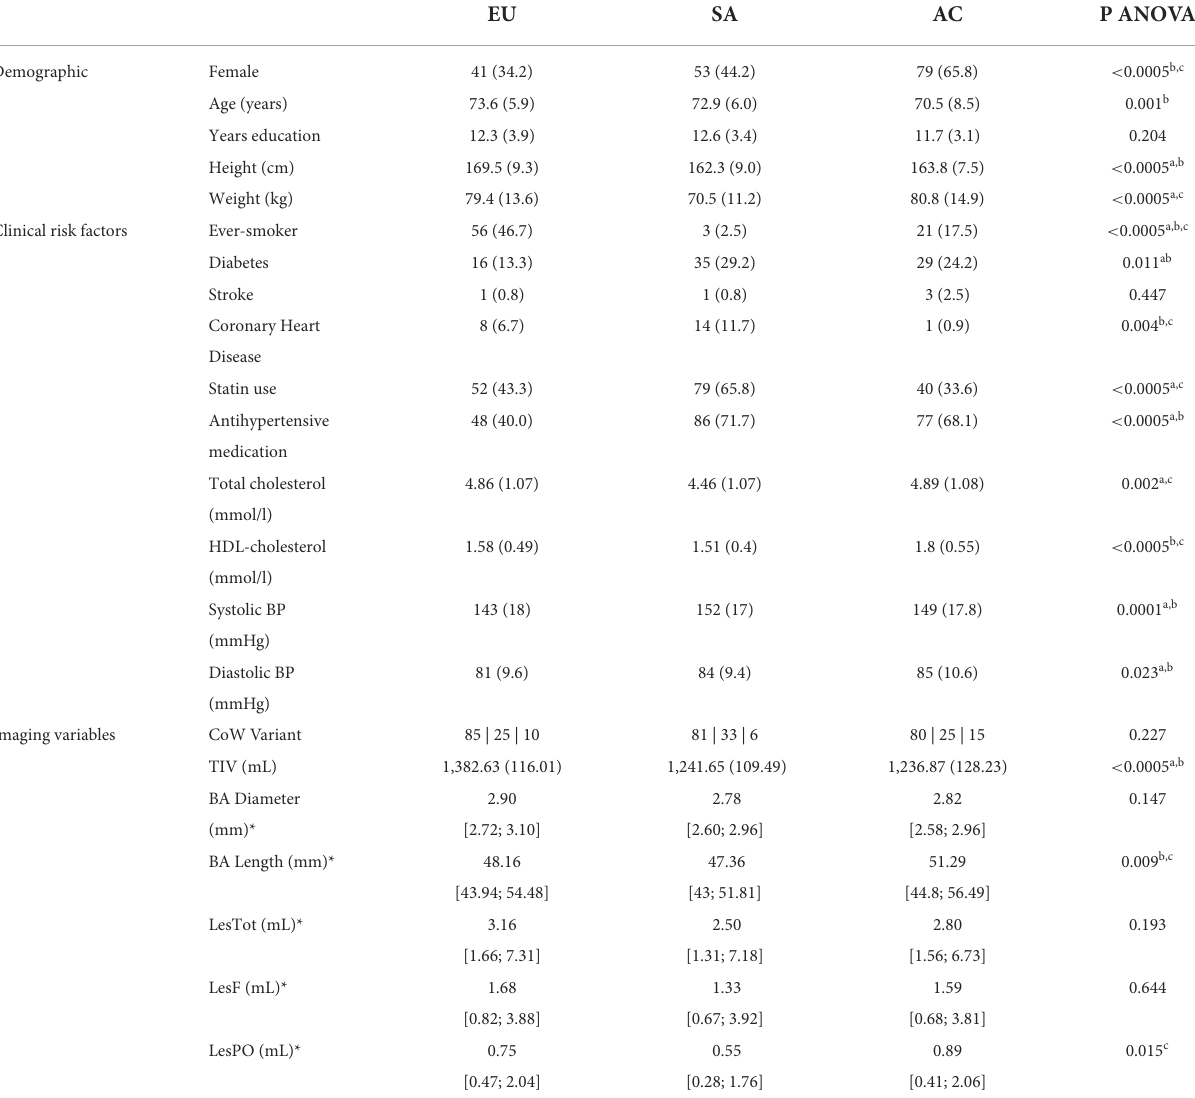
TABLE 1 Demographic, clinical and imaging data stratified by ethnicity.